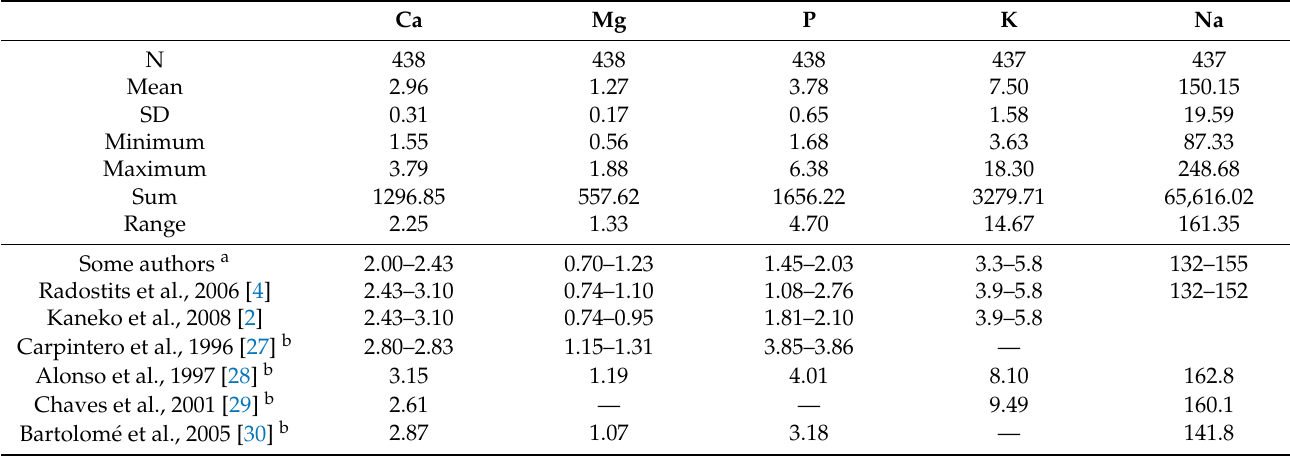
Table 1. Mineral values (macrominerals) in bull plasma after intense exercise: descriptive statistics. Values indicated by other authors are also